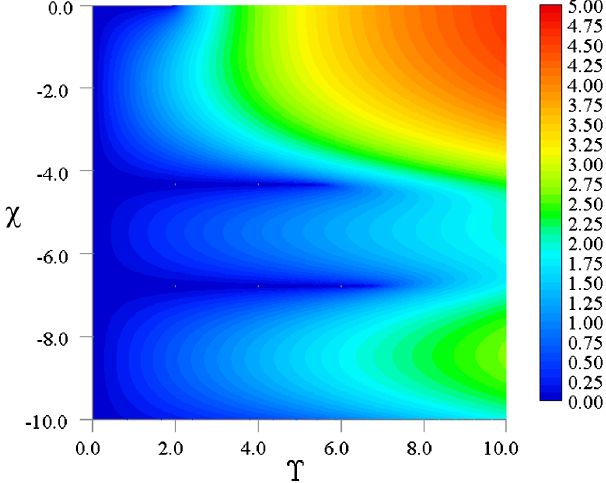
g × T as a function of ϒ and χ for positive χ . s